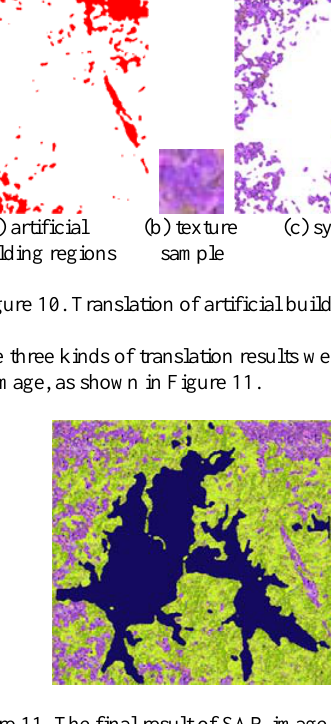
Figure 11. The final result of SAR image translation